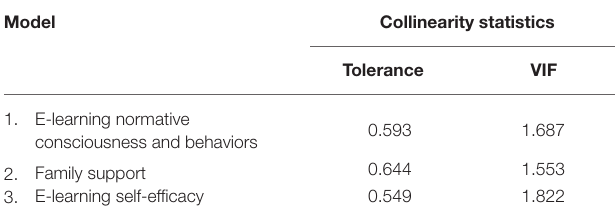
TABLE 3 | Collinearity diagnosis among variables in the